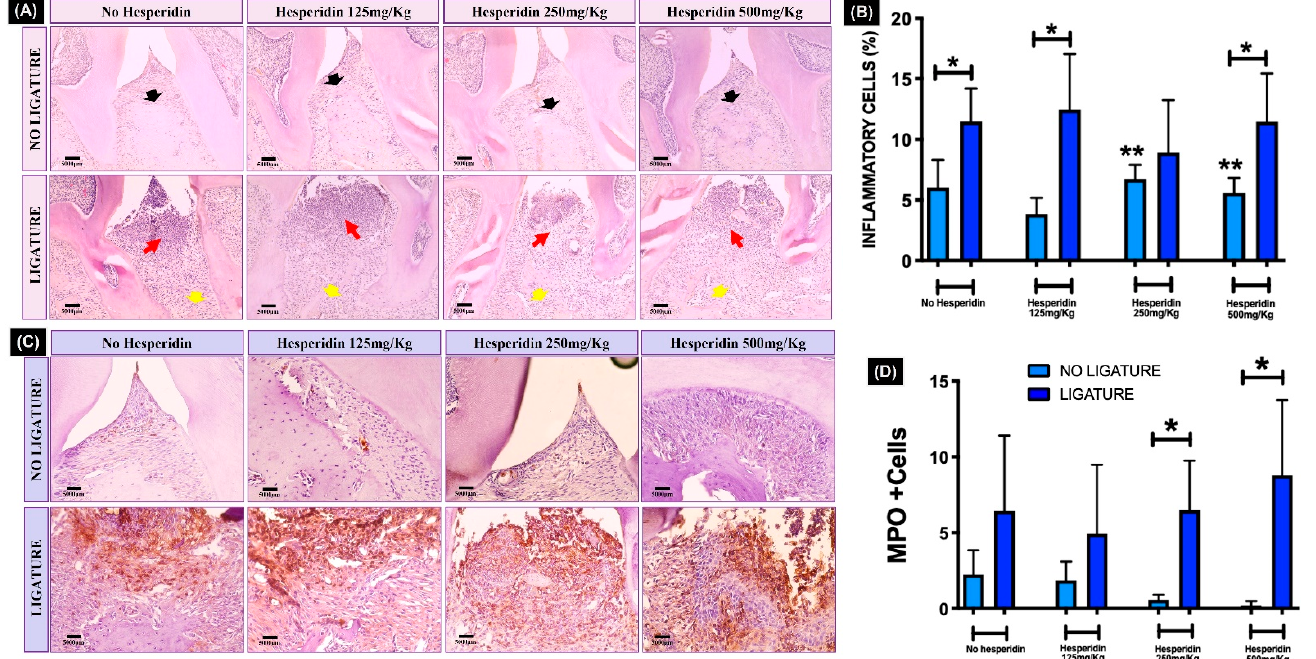
Figure 4. Histopathological and stereometric evaluation of the periodontal tissues (H&E and immunohistochemistry). ( A ) In the representative images from each group, black arrows indicate the integrity of alveolar bone crest in the groups of animals that did not receive ligature, while marked bone resorption (yellow arrows) can be seen in the ligature groups. Red arrows indicate the presence of clear inflammatory gingival infiltrate in all groups with experimental periodontitis confirmed by stereometry ( B ) showing a significant increase in inflammatory cells compared to the no-ligature groups. * p < 0.05 comparing ligature and no-ligature groups. ** p < 0.05 Hesperidin 250 and 500 mg/kg compared to lower dose of hesperidin and no ligature. Complementary to these findings, the myeloperoxidase (MPO)-positive cells, stained in brown via immunohistochemistry ( C ), were increased in all ligature groups and were significantly increased for 250 and 500 mg/kg hesperidin-treated ligated mice compared to their respective no ligature counterpart (* p < 0.05) ( D ). Photomicrographs—20 × magnification.